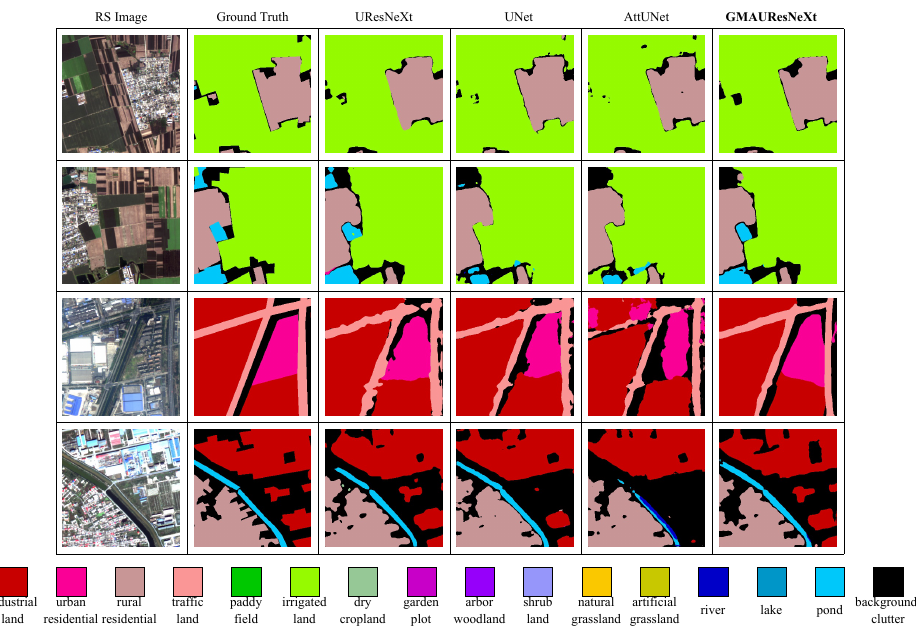
Figure 7. Qualitative comparisons of the segmentation results for the GID generated by different semantic segmentation approaches.